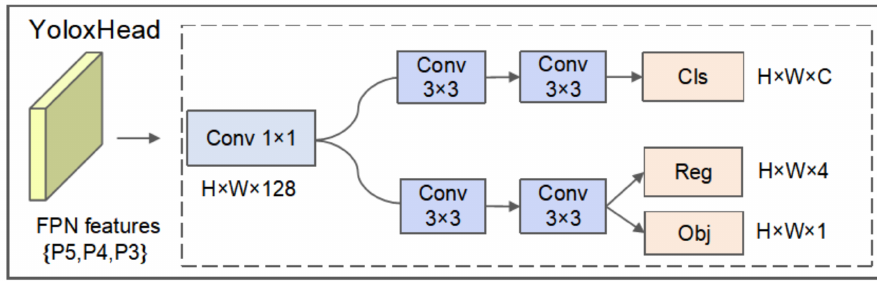
Figure 5. The structure of the decoupled head in